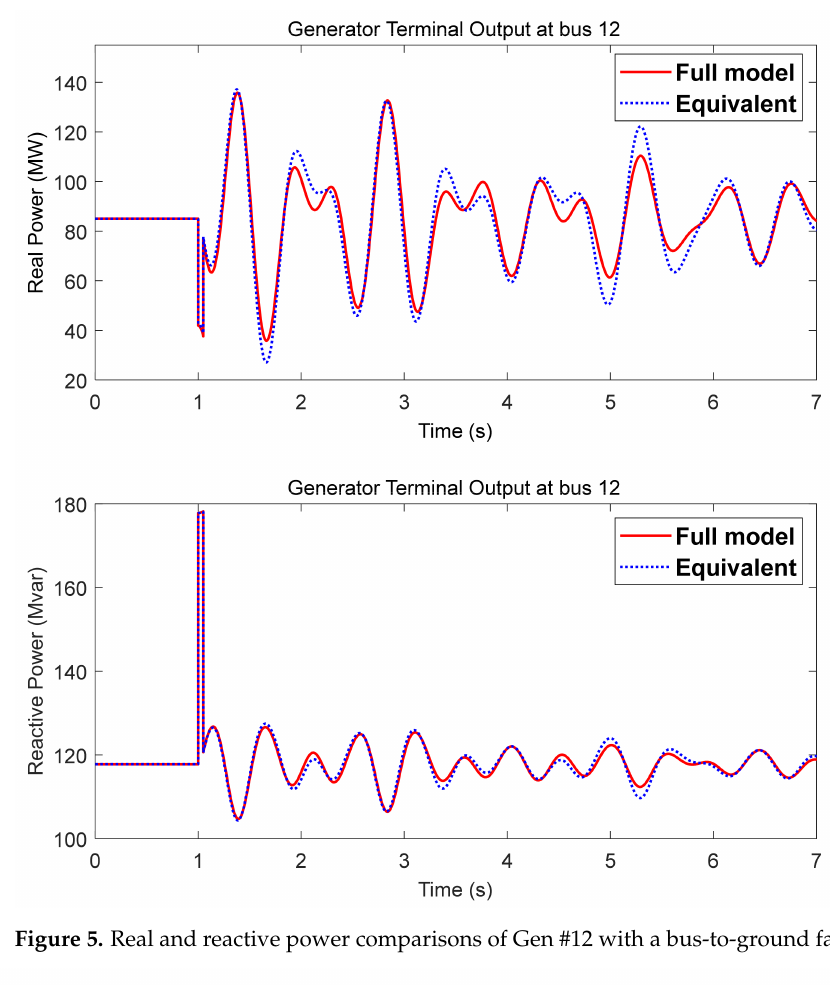
Figure 5. Real and reactive power comparisons of Gen #12 with a bus-to-ground fault at bus 1.